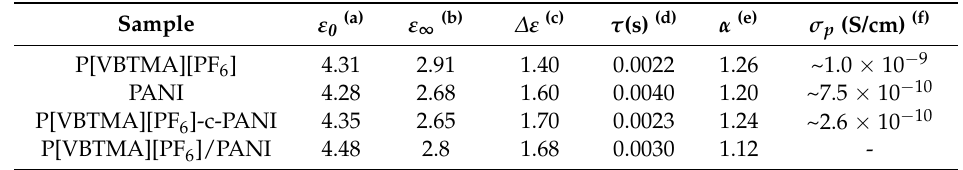
Table 2. Dielectric characteristics of the suspensions of P[VBTMA][PF 6 ], PANI, P[VBTMA][PF 6 ]-c-PANI (40 wt %), and P[VBTMA][PF 6 ]/PANI (40 wt %) mixture ( ϕ = 15 vol %, T = 23 ◦